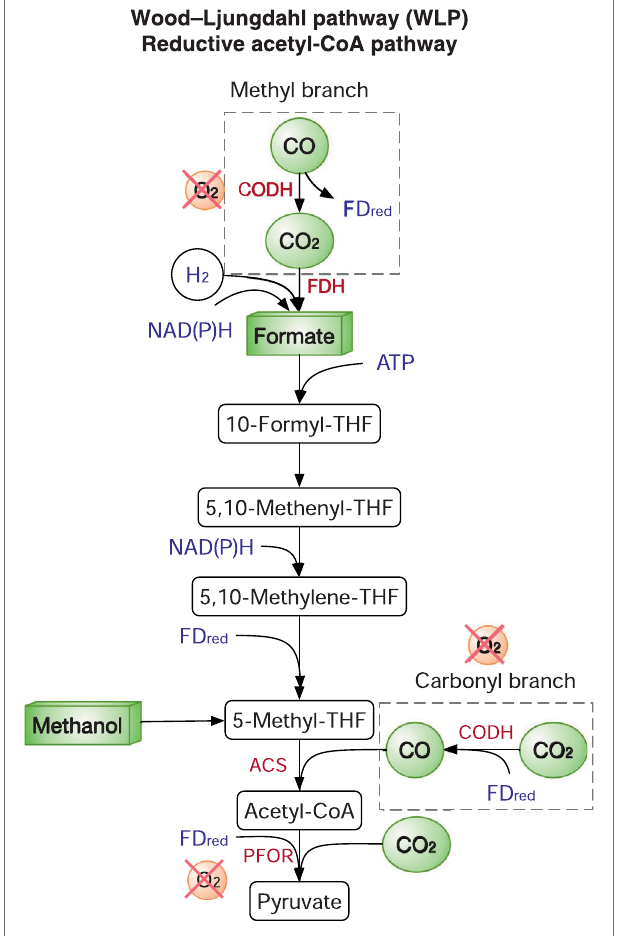
FIGURE 3 | The Wood-Ljungdahl pathway (WLP). Enzymes: ACS, acetyl-CoA synthase; CODH, carbon monoxide dehydrogenase; FDH, ormatedehydrogenase; PFOR, pyruvate:ferredoxin oxidoreductase. Metabolites/cofactors: THF, tetrahydrofolate; FD red , reduced ferredoxins. Reduced cofactors (ATP, NAD(P)H, FD red ) are in blue. Genes/ enzymes are in red.